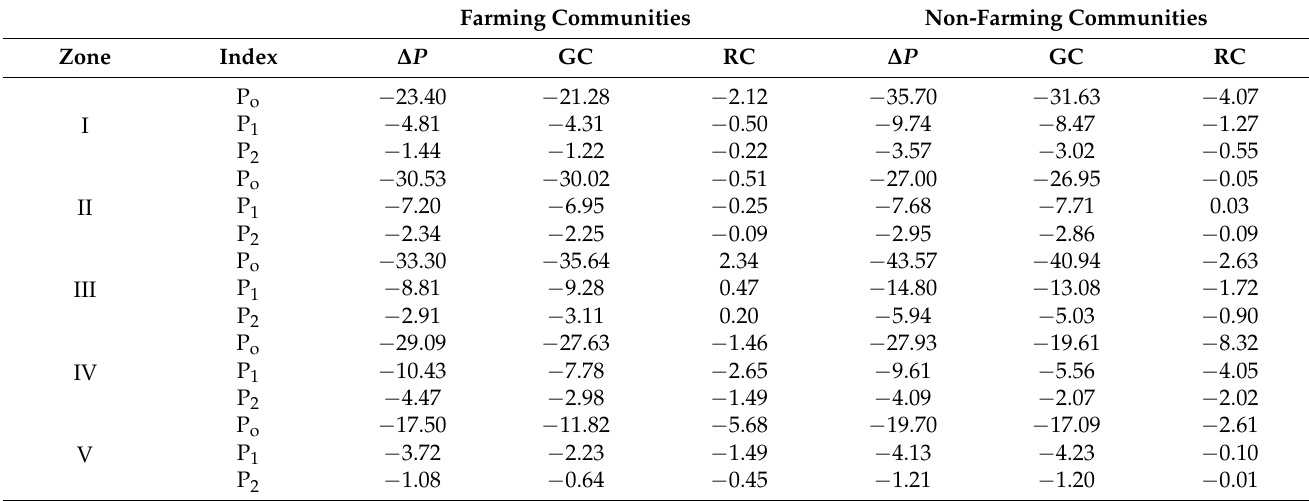
Table 5. Decomposition of the change in poverty into growth and redistribution components. Farming Communities Non-Farming